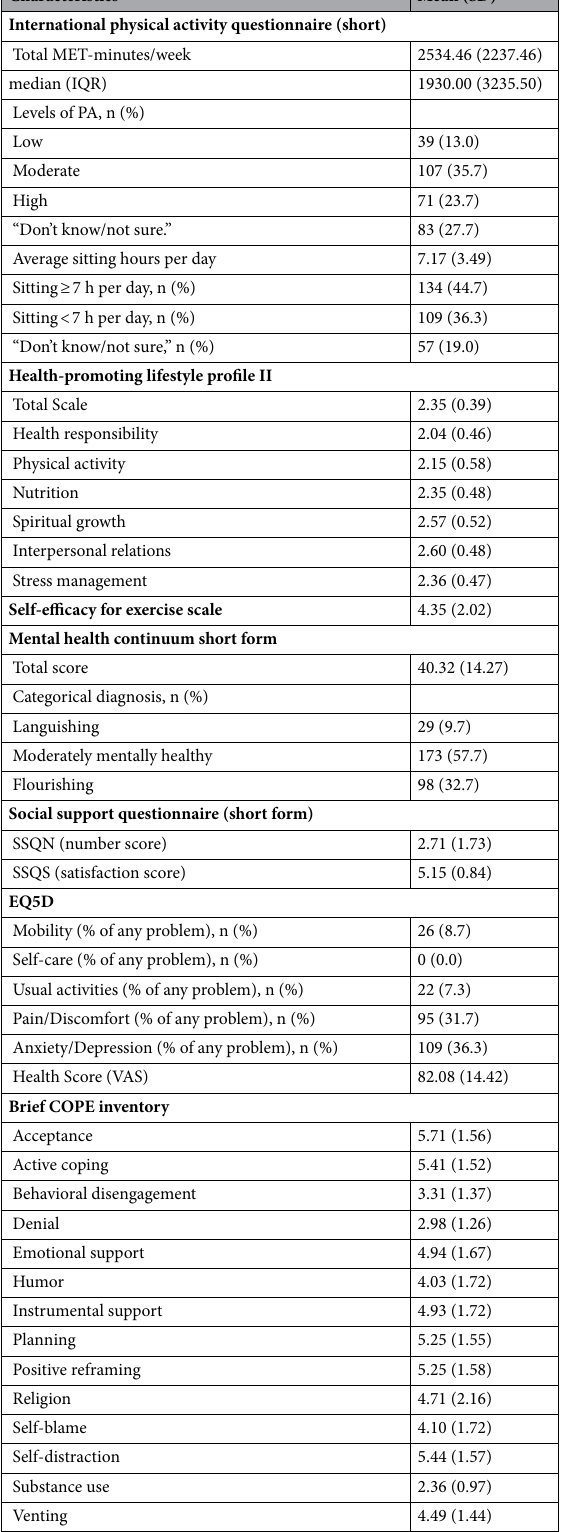
Table 3. Descriptive statistics for outcome